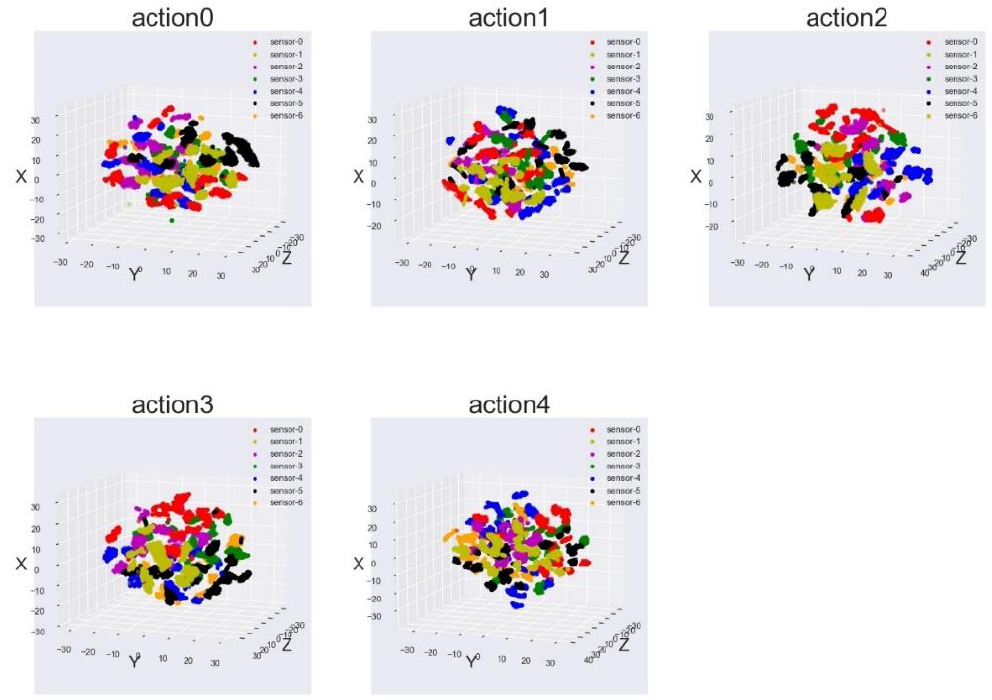
Figure 20. Visualization of local feature vectors of table tennis actions (raw inertial data) for each category.